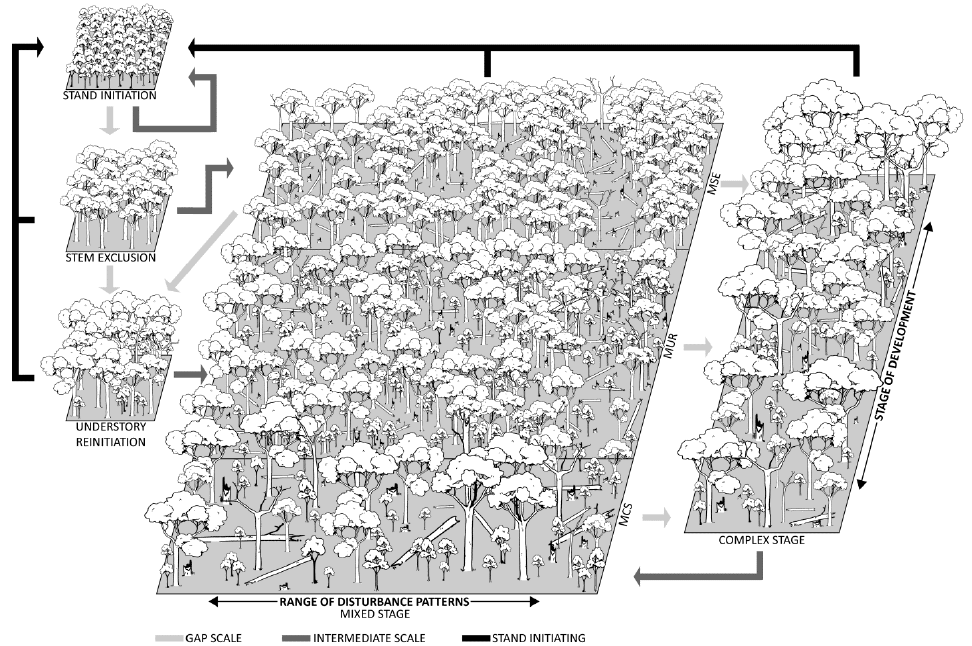
Figure 2. Conceptual model of oak stand development shaped by canopy disturbance events. Light gray lines indicate the developmental pathway driven by gap ‐ scale disturbances, medium gray lines by intermediate ‐ severity disturbances, and black lines by catastrophic disturbances. Note the variability of residual stand structures after intermediate ‐ severity disturbance events is depicted to vary left to right from uniform to aggregated to linear patterns of tree mortality based on disturbance agent. The mixed stage is also depicted to vary top to bottom based on pre ‐ disturbance condition (MSE: mixed stage from stem exclusion, MUR: mixed stage from understory reinitiation, and MCS: mixed stage from complex stage). Likewise, a wide range of structural conditions is depicted in the complex stage based on disturbance history.